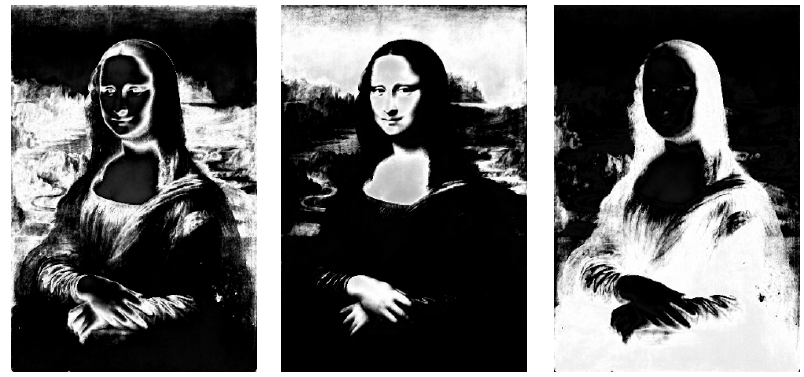
Figure 4. Mona Lisa G Band—compression rate 0.25—segmented images.